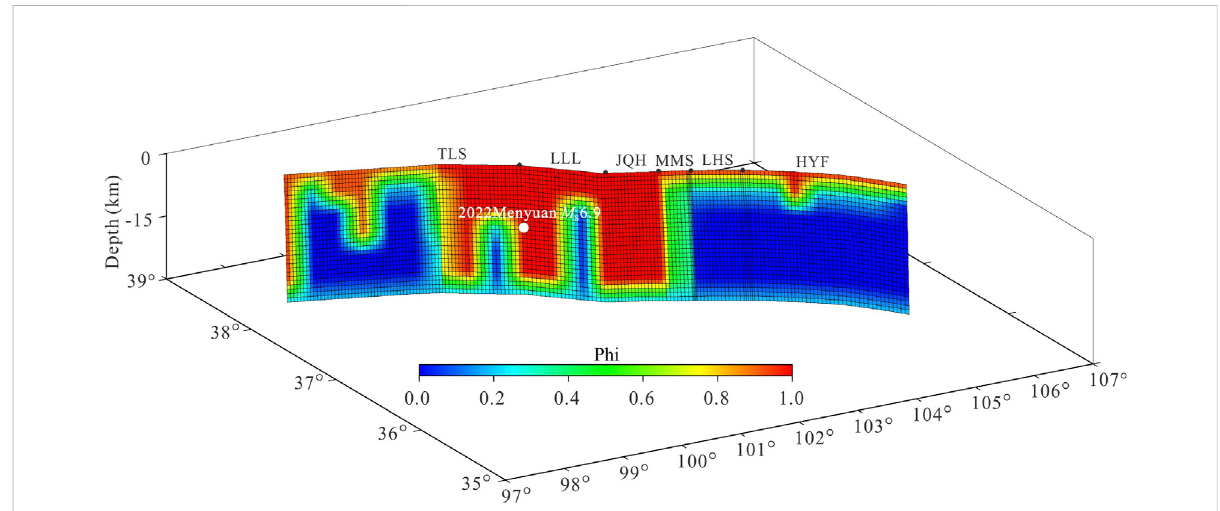
FIGURE 5 LockingdegreeoftheQilian – Haiyuanfaultzone.HypocenterparameterswereobtainedfromGlobalCMTCatalog(http://www.globalcmt.org/ CMTsearch.html). TLSF: Tuolaishan fault; LLLF: Lenglongling fault; JQHF: Jinqianghe fault; MMSF: Maomaoshan fault; LHSF: Laohushan fault; HYF: Haiyuan fault.